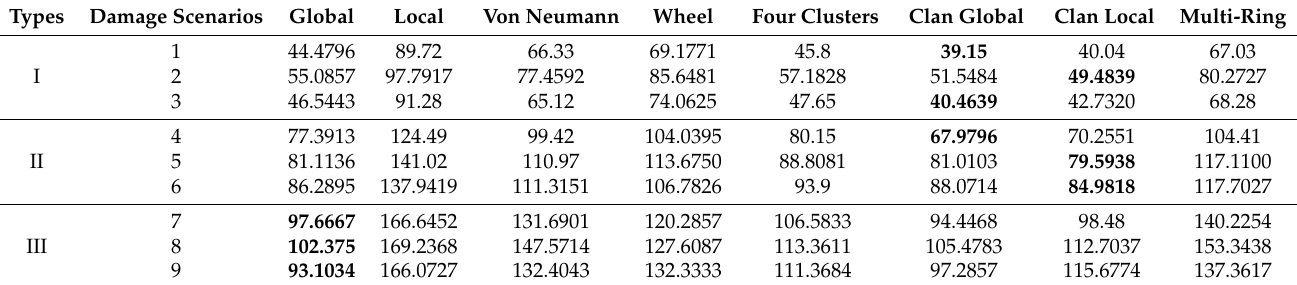
Table 4. Comparison results of mean iterations for each damage scenario among the PSO topologies.